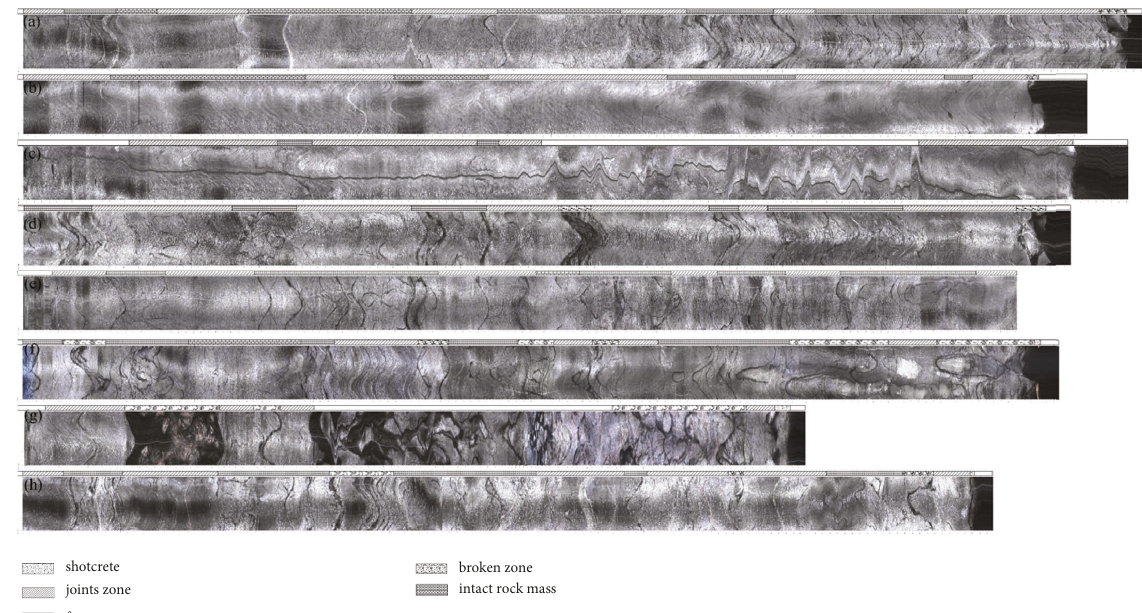
Figure 10: Image of II and III grade surrounding rock of vertical hole. (a) Hole No. 3. (b) Hole No. 5. (c) Hole No. 6. (d) Hole No. 7. (e) Hole No. 8. (f) Hole No. 12. (g) Hole No. 14. (h) Hole No.